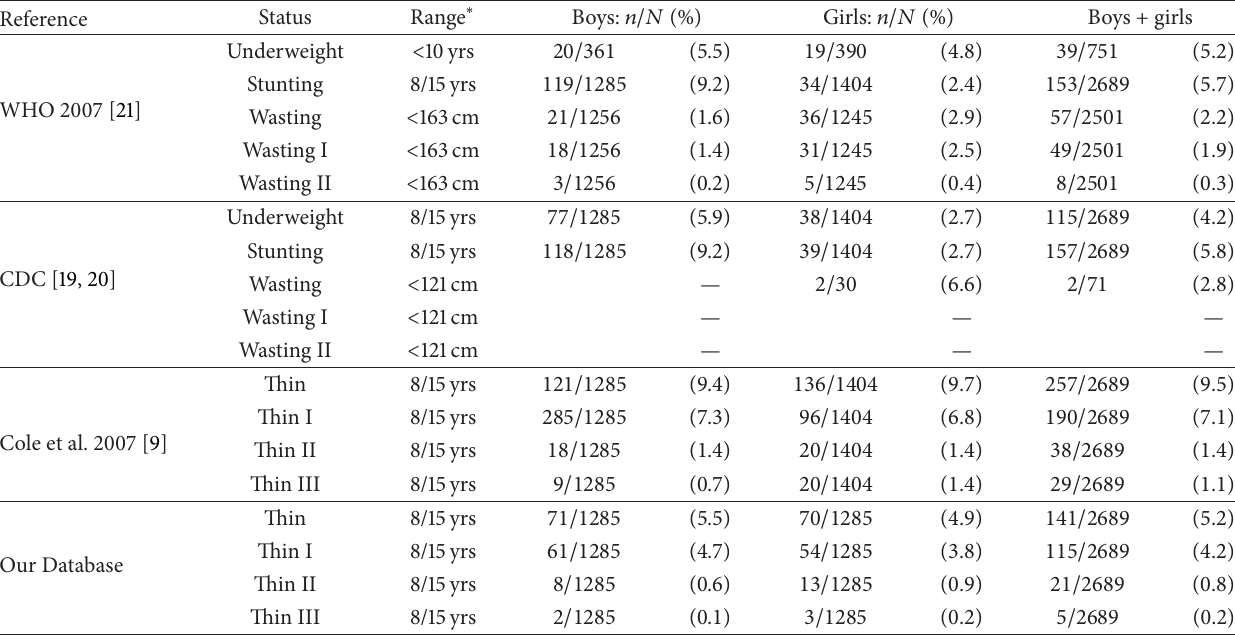
Table 6: Prevalence of undernutrition defined as underweight (low weight for age), stunting (low height for age), wasting (low weight for height) and thinness (low BMI for age) based on several references used: WHO 2007, CDC, Cole et al. 2007, and our Database.